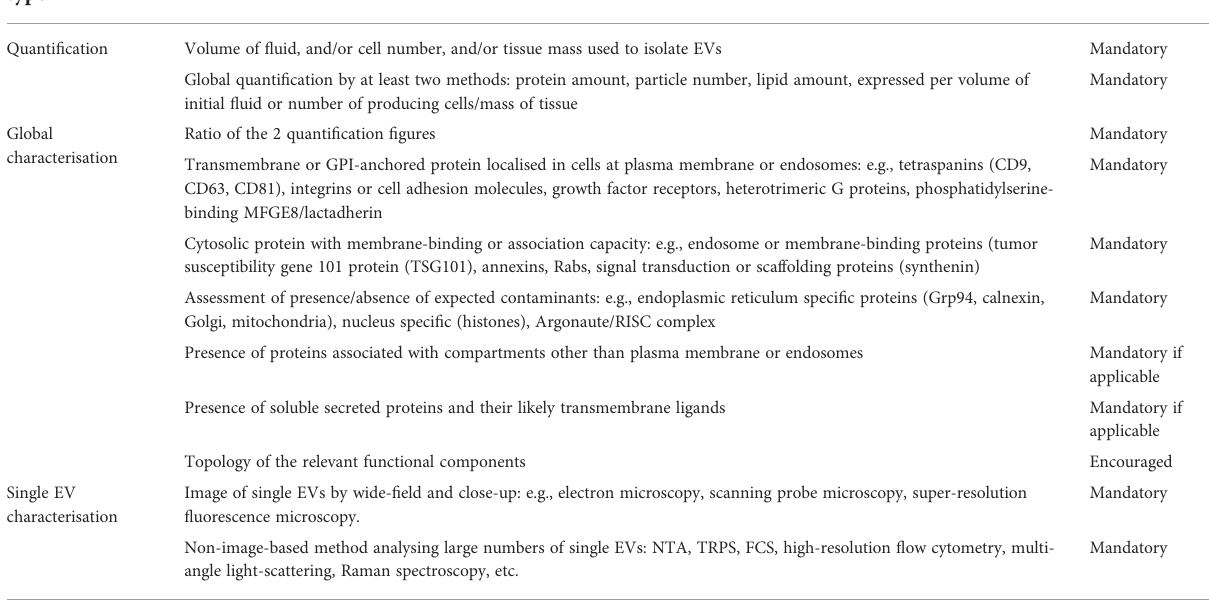
TABLE 3 EV characterisation methods